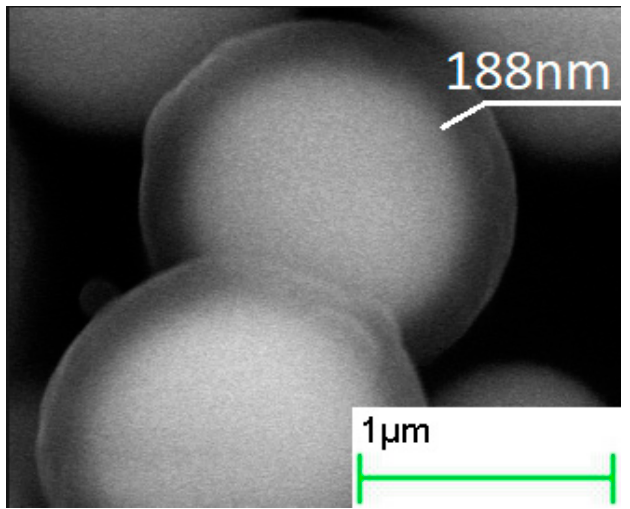
Figure 3. SEM images of core–shell particles obtained in the processes with 2 h hydrolysis duration.